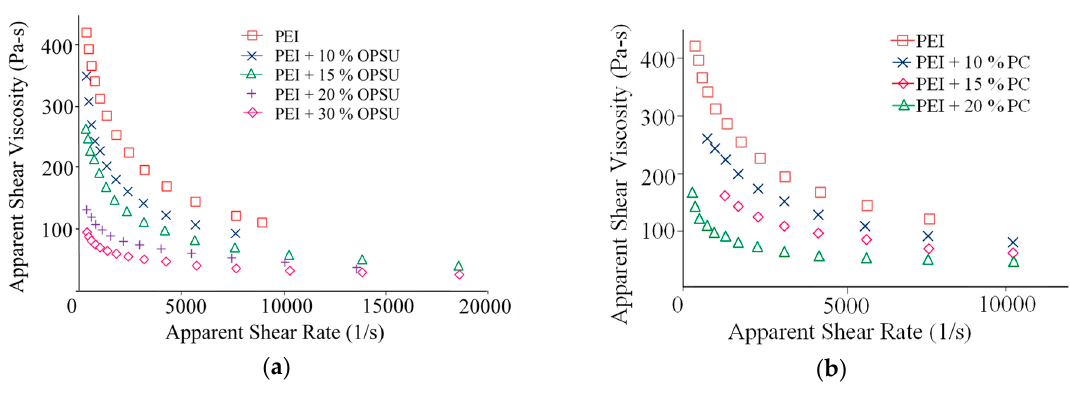
Figure 3. The dependence of the PEI melt viscosity on the content of OPSU ( a ) and PC ( b ).